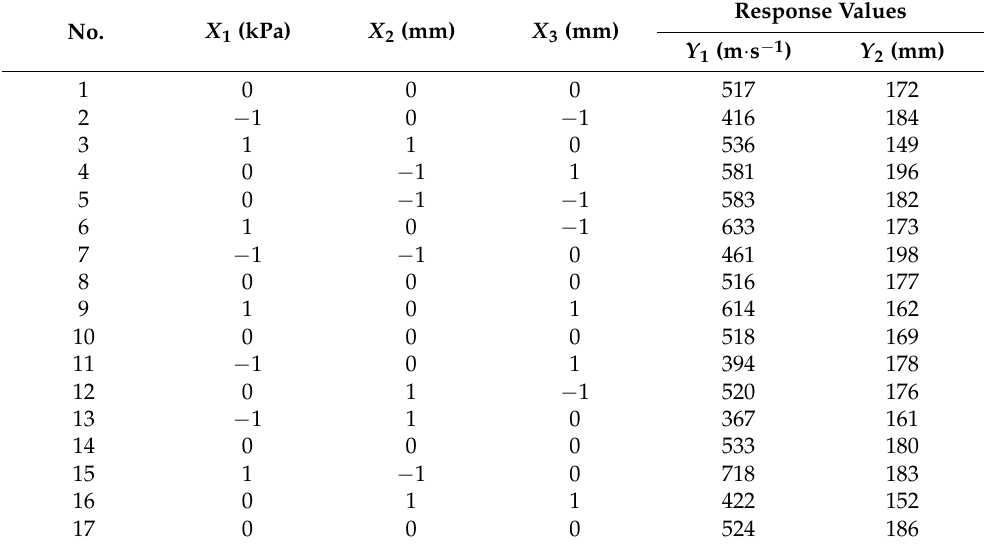
Table 3. Experiment combinations and